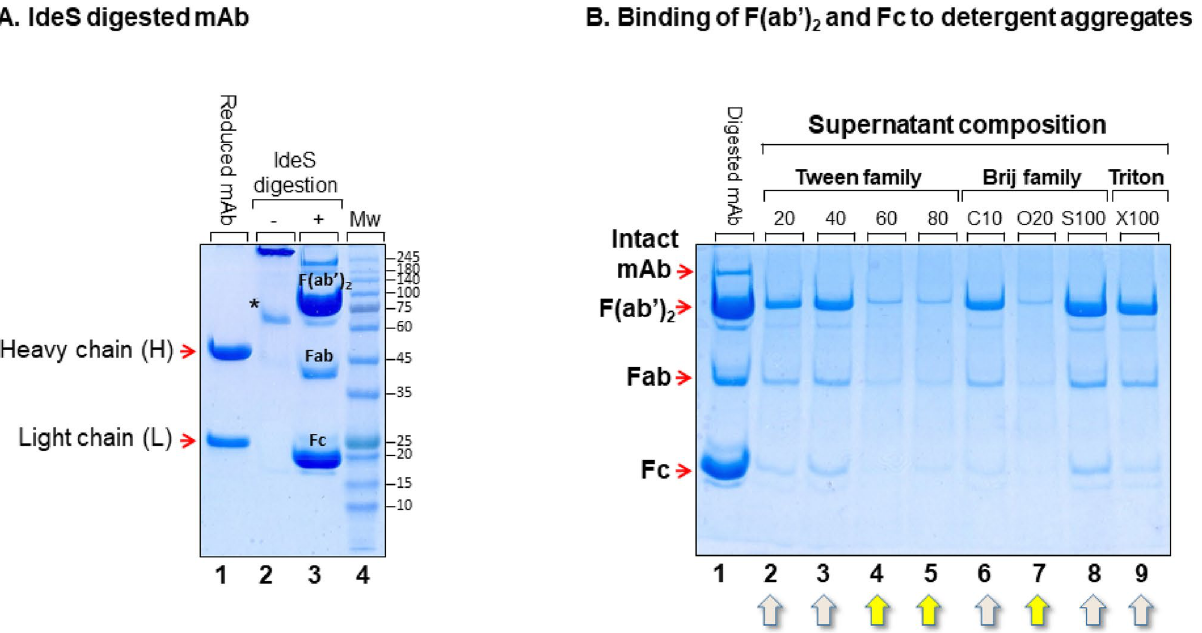
Figure 2. ( A ) Digestion of mAb with papain. Lane 1: reduced mAb; lane 2: unreduced mAb; lane 3: IdeS digested mAb. The asterisk indicates a minor antibody fragment with unknown identity that seems to contain disulfide bonds due to its disappearance upon reduction in lane 1. ( B ) Supernatant composition after brief incubation of detergent aggregates (as indicated) with IdeS cleaved mAb. Yellow arrows point to detergent aggregates that bind all three major fragments (i.e. Fab, F(ab ′ ) 2 and Fc). Grey arrows point to detergent aggregates that preferentially bind the Fc domain. Gels are Coomassie